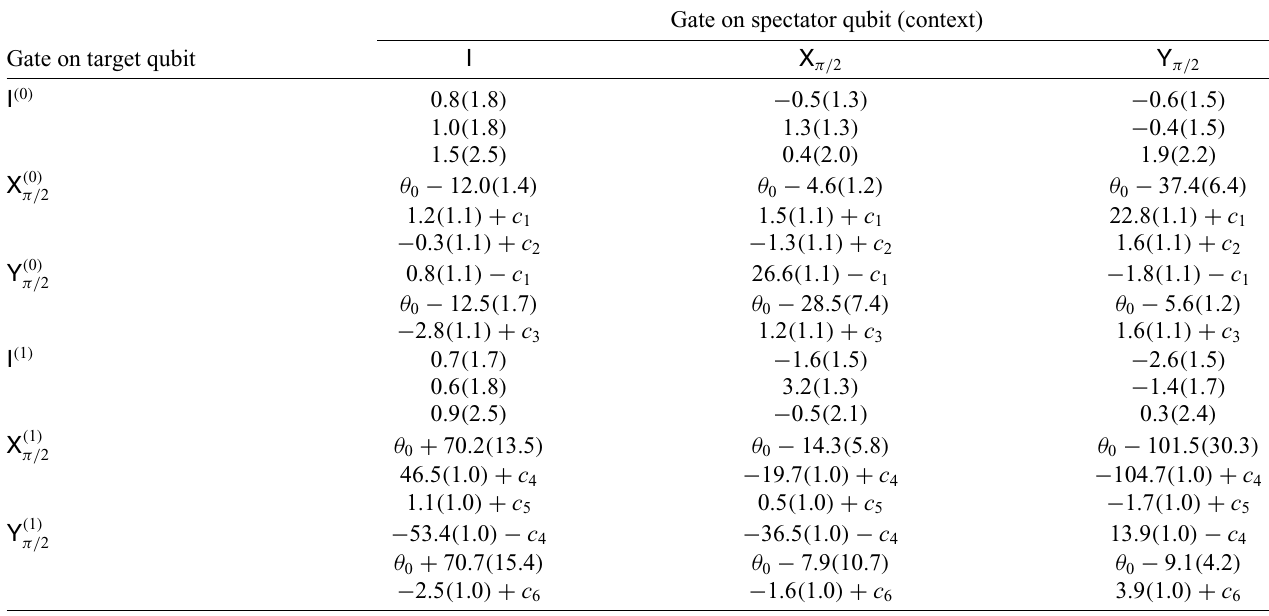
TABLE V. Estimated rates (in milliradians) of all Hamiltonian (unitary) errors, on all gates, in all contexts, for the context-dependent model of the QSCOUT platform. Each column of three values is the three components unitary part of the estimated process (see the main text), represented as H eff = freedoms, which are reflected in this table by the unobservable constants c 1 , . . . , c 6 . Any value, or linear combination of values, that does not contain any c ’s is gauge invariant, and therefore physically meaningful. All values have been shifted relative to the target value, θ 0 = π/ 4 rad (cid:15) 785.4 mrad, where